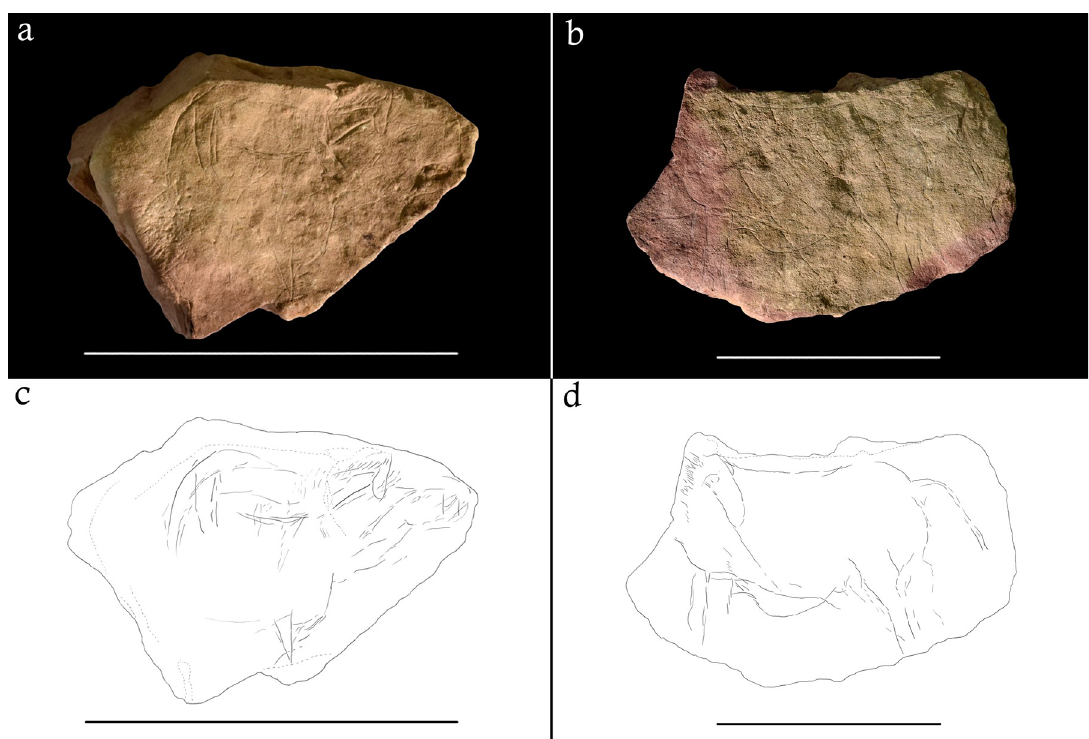
Fig 1. Photographs and digital tracings of plaquettes 675 (a; c) and 667 (b; d) from Montastruc. Scale bar below each plaquette is 10cm in length.